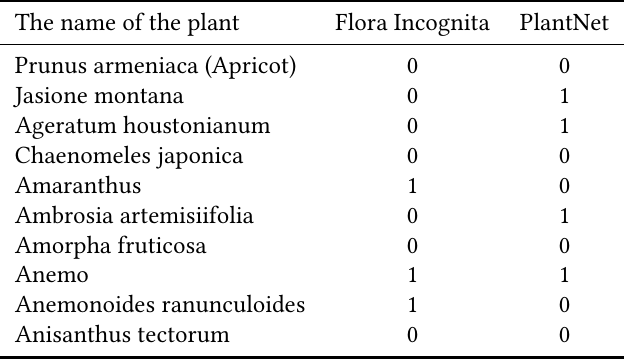
Example of the table of apps analyzing The name of the plant Flora